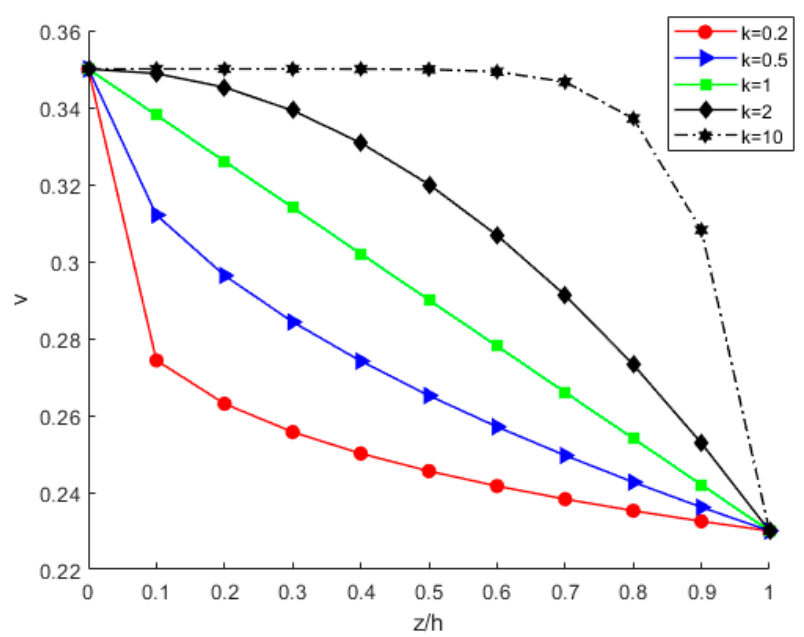
Figure 11. Variation in Poisson ratio through the thickness direction of the FGM plate.